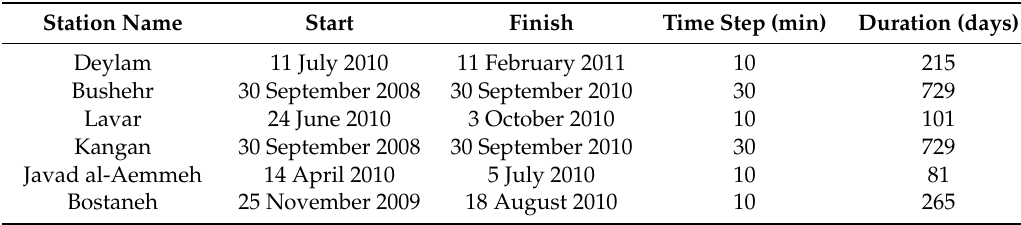
Figure 1. Location of sea-level observations (red triangles) and meteorology stations (yellow boxes) located along the northern coasts of the Persian Gulf (Image from Google Map: https://goo.gl/maps/MAU6TJCNbFGXoDzU6). Table 1. Sea-level data along northern Persian Gulf coasts.